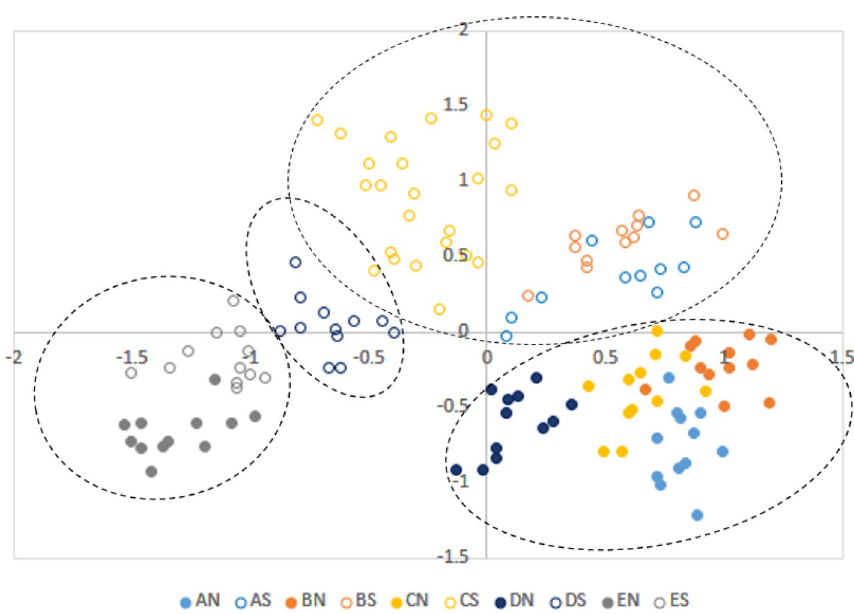
Figure 2. Ordination representing ant species assemblages relative to altitude (Categories: A = 810–990 m; B = 991–1170 m; C = 1171–1350 m; D = 1351–1530 m; E = 1531 m–1710 m) and aspect ( N northern, S southern). Dashed groupings represent assemblages similar at 30% or more.